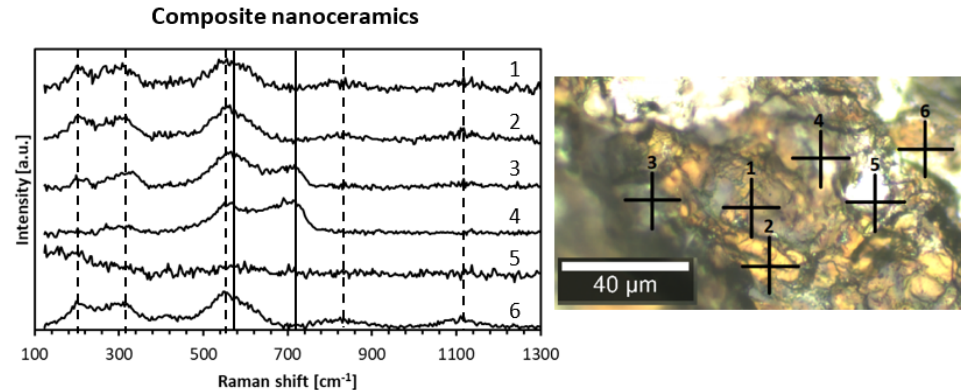
Figure 9. Raman spectra ( left ) for nanoceramics of Composite_950_sint_1000 at points 1–6 ( right ). Vertical lines are shift positions for various modes of TiN (dashed) and GaN (solid) and serve as guides for the eye, only.